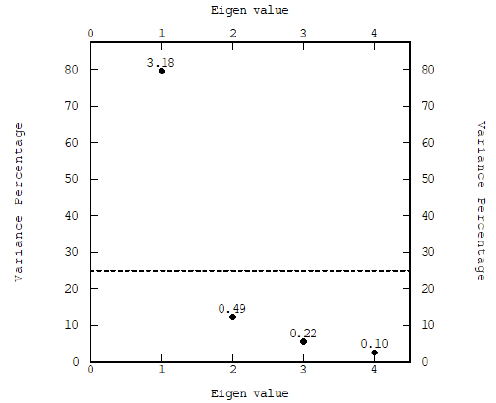
Figure 11. Projection of the quality parameters on the plane spanned by the first two factors of the Principal Component Analysis (PCA).